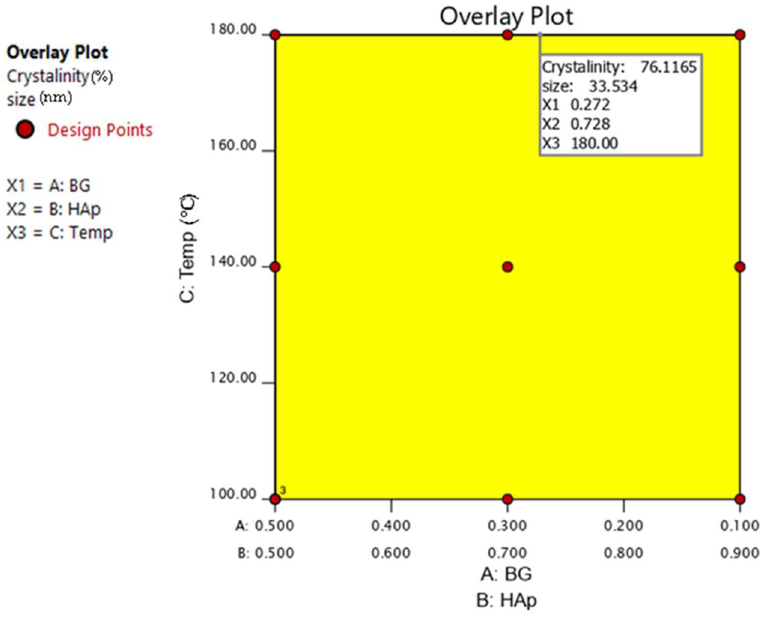
Figure 11. Overlay plot, showing the optimal point of each component and process factor in the composite.